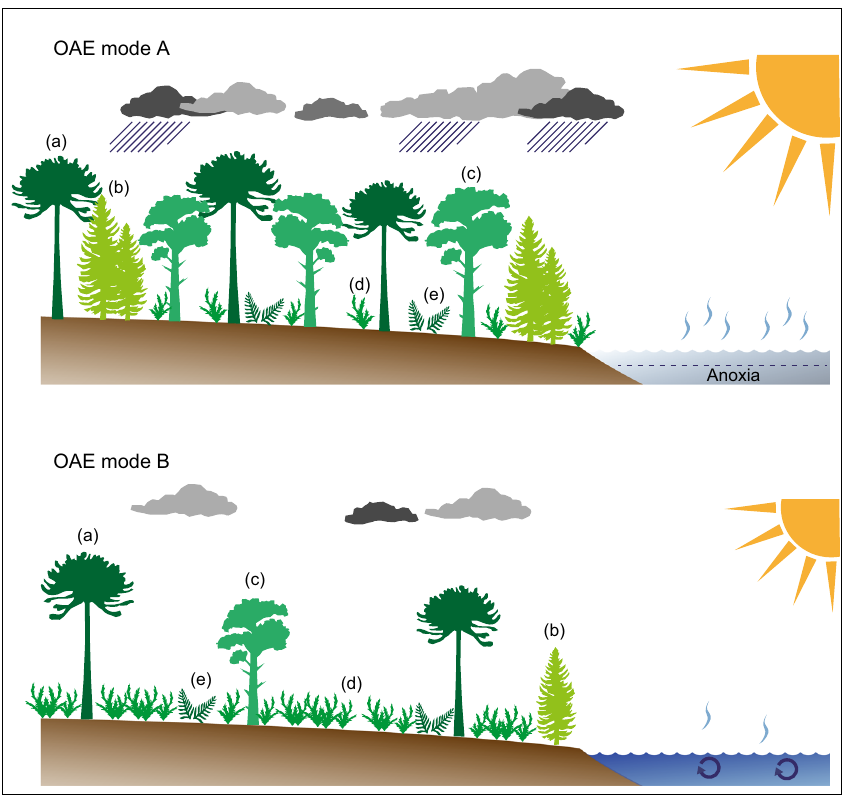
Fig. 4 Tentative changes in mid-latitude vegetation patterns during OAE2. During OAE mode A (e.g. represented by AZ II, IV and VI), the prevailing climate was characterized by exceptional warmth and high moisture availability, giving way to conifer-dominated forests with moderate angiosperm contribution. During OAE mode B (AZ III and V), climatic conditions were cooler and less humid resulting in an open, savanna-type vegetation community with increased abundances of Normapolles-producing angiosperms. ( a ) Araucariaceae, ( b ) other conifers incl. Cheirolepidiaceae, ( c ) Cupressaceae, ( d ) angiosperms incl. Normapolles-producing forms, ( e )